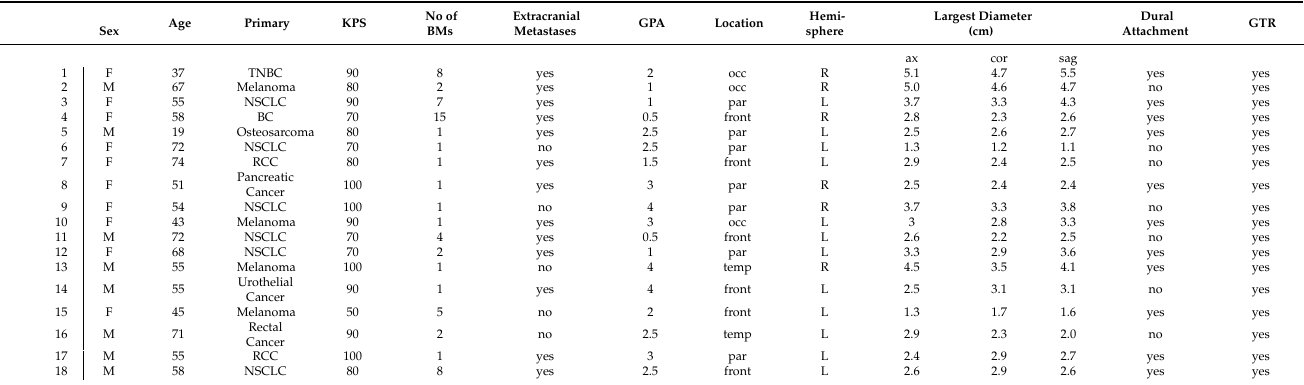
Table 1. Patient demographics and tumor characteristics for 18 patients undergoing IORT. TNBC: triple negative breast cancer, L: left, R: right front: frontal, temp: temporal, par: parietal, occ: occipital.